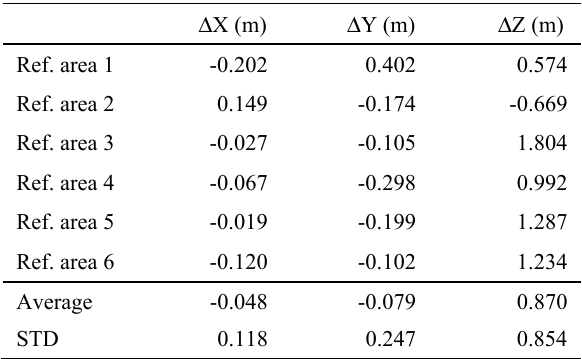
Table 2. The comparison of relatively oriented and